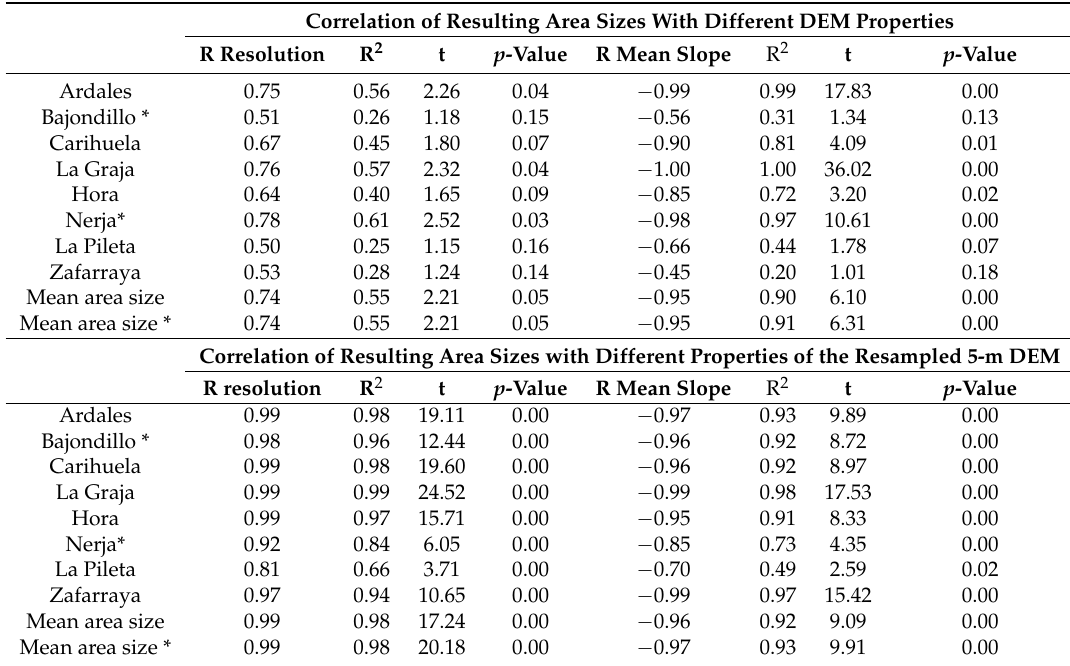
Table 7. Statistical evaluation of the correlations between area size, DEM resolution, mean slope. * = sites are located near the coast and excluded from the calculation of the mean area size. Correlation of Resulting Area Sizes With Different DEM Properties